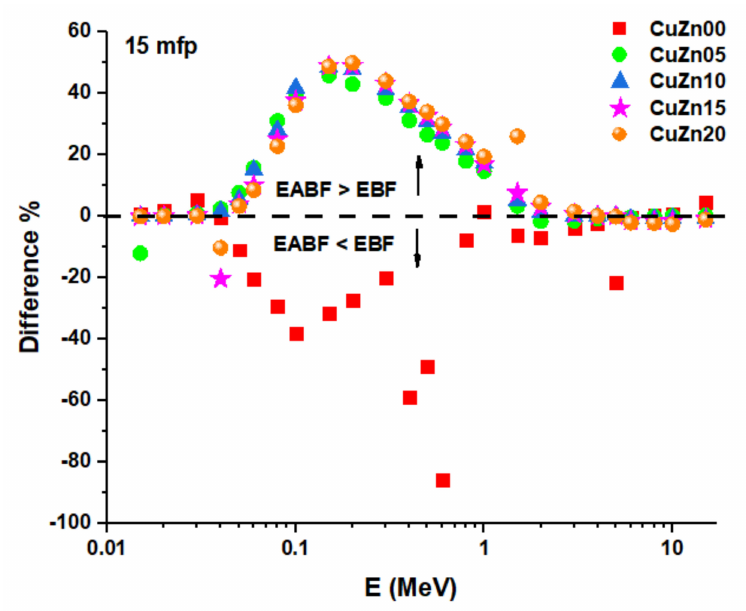
Figure 13. Difference between energy absorption buildup factor (EABF) and exposure buildup factor (EBF) of samples at 15